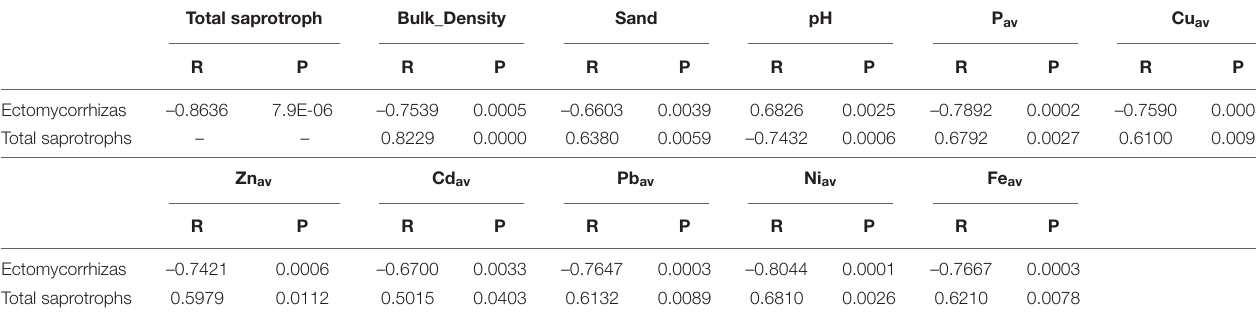
TABLE 5 | Pearson correlation between the Shannon Index values of the ectomycorrhiza, the saprotrophic fungi and soil chemico-physical parameters. Total saprotroph